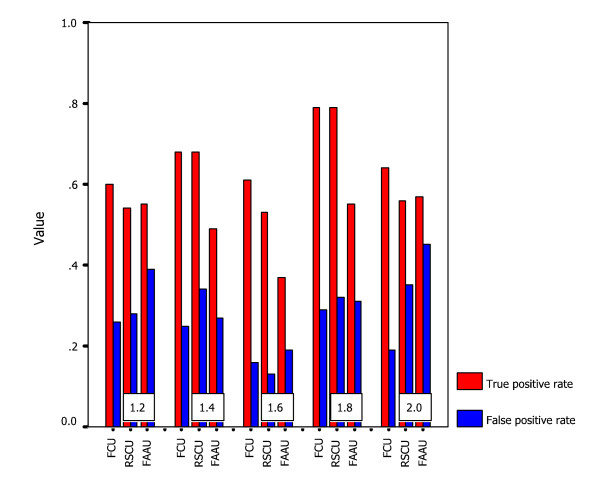
The performance of SVM for predicting hot ORFs from the full genome. The numerical value stuck on each bar cluster denotes the recombination rate cutoff of hot ORFs.